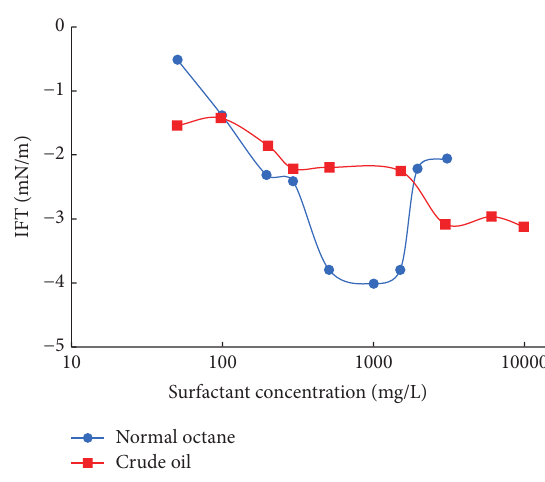
Figure 3: IFT between normal octane and crude oil